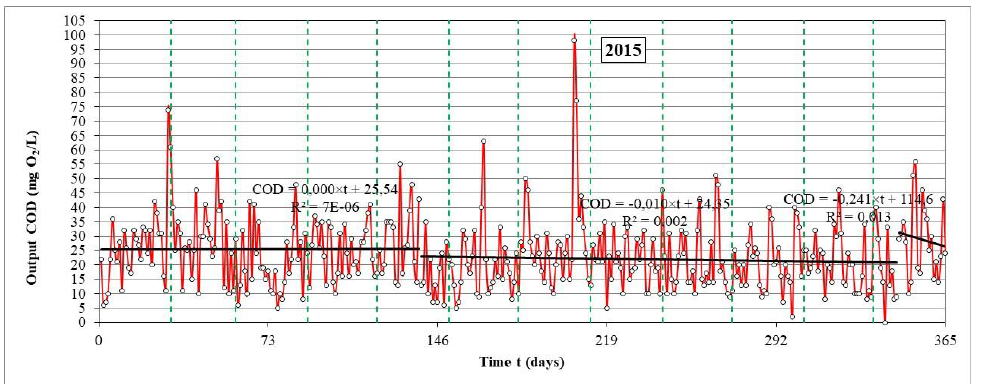
Figure 7. Subseries of the output COD for the year 2015.